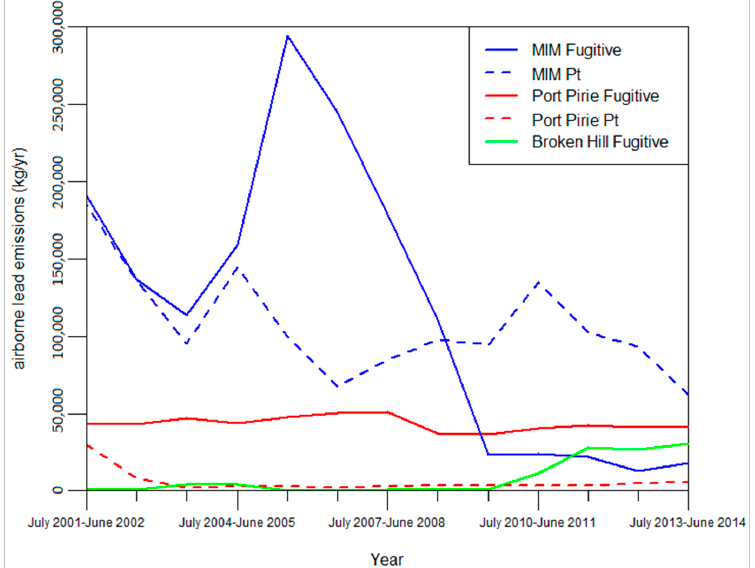
Figure 3. Point source and fugitive NPI emission estimates for Mount Isa Mines, Port Pirie Smelter, and Broken Hill Mines [17].